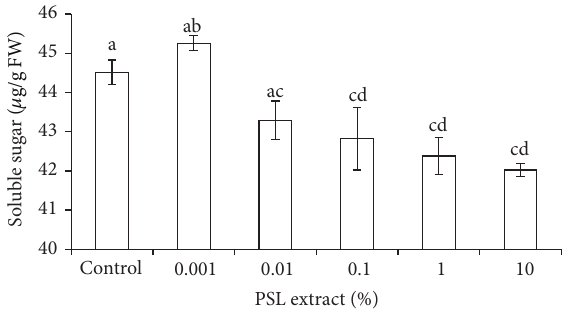
Figure 2: Effect of PSL extract on sugar contents of wheat. Error bars represents Mean ± S.D of three different experiments. Data were subjected to one-way ANOVA analysis and differences among treatments were determined by Tukey’s test. Different letters mean statistical differences at 𝑃 < 0.05 .